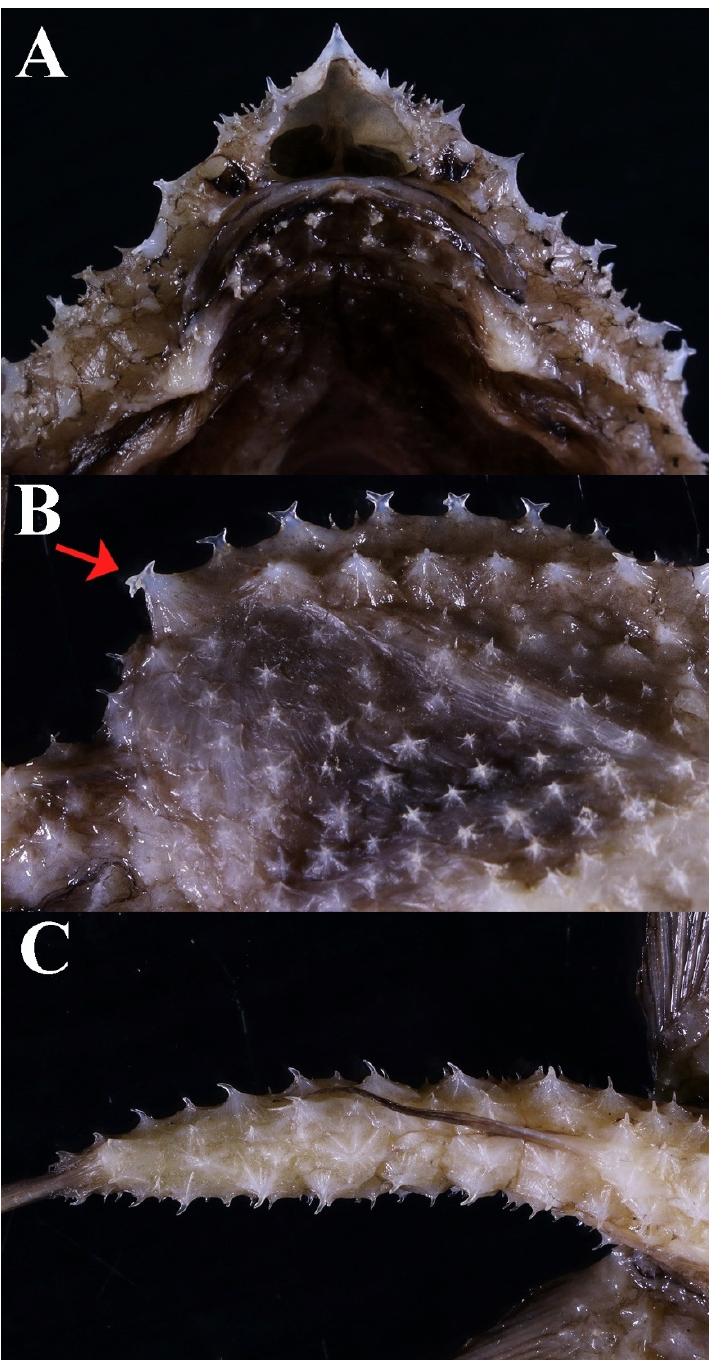
Figure 13. Halieutopsis kawaii sp. November ( A , B ). Holotype, ASIZP66383, 79.4 mm SL, preserved, photos by C.-N. Teng. ( C , D ). Paratype, HUMZ194271, 83.6 mm SL, fresh, photos courtesy of HUMZ. ( A , C ). Dorsal view. ( B , D ). Ventral view.